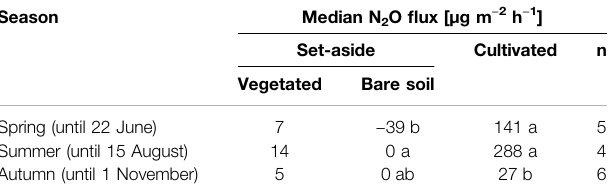
TABLE 5 | Season-speci fi c median nitrous oxide (N 2 O) fl ux [µg m − 2 h − 1 ] from the set-aside site (SA-bare and SA-veg) and the cultivated site.